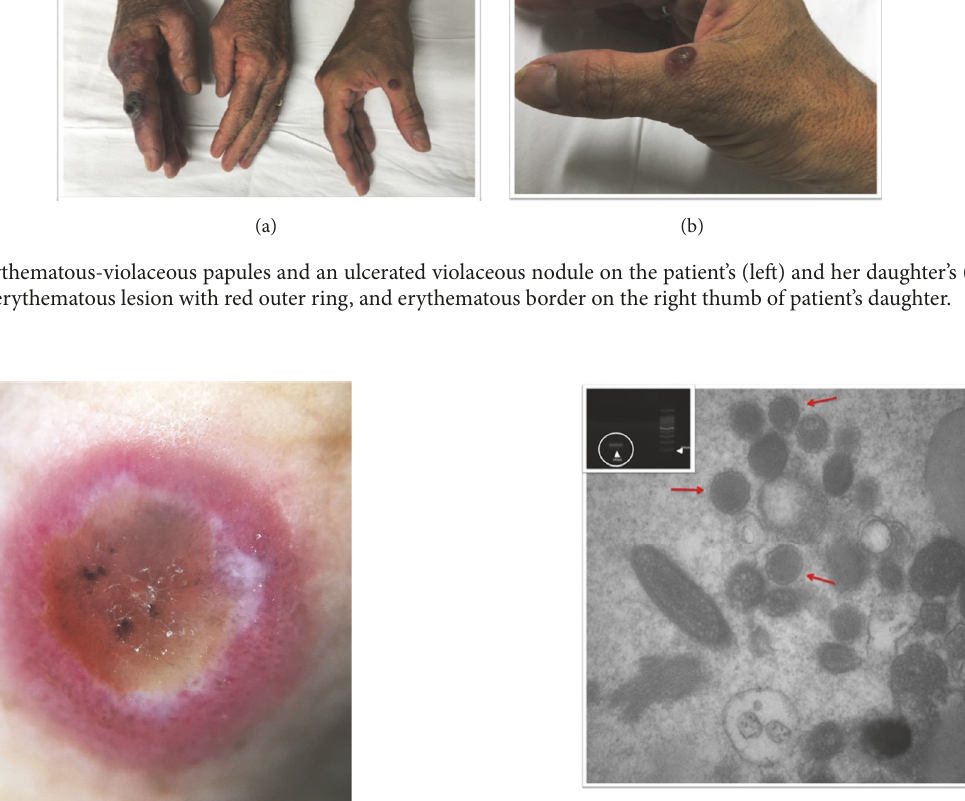
Figure 2: Dermoscopy showed an erythematous area, central ulceration, yellow crust, brown dots, a white structureless zone partially surrounding it, and dotted vessels; original magnification x10 (DermLite II Pro 3Gen, San Juan Capistrano, CA, USA).